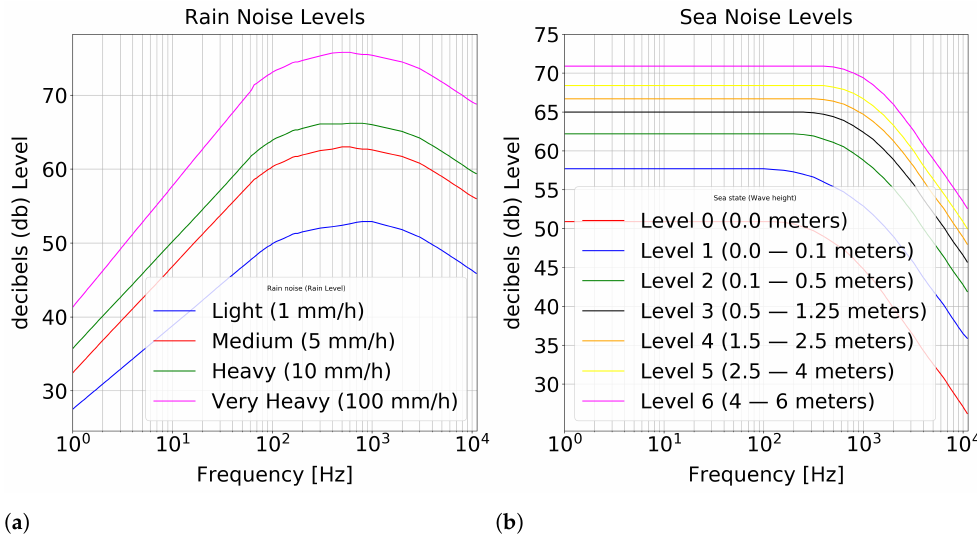
Figure 7. Spectral behavior for the rain ( a ) and sea ( b )